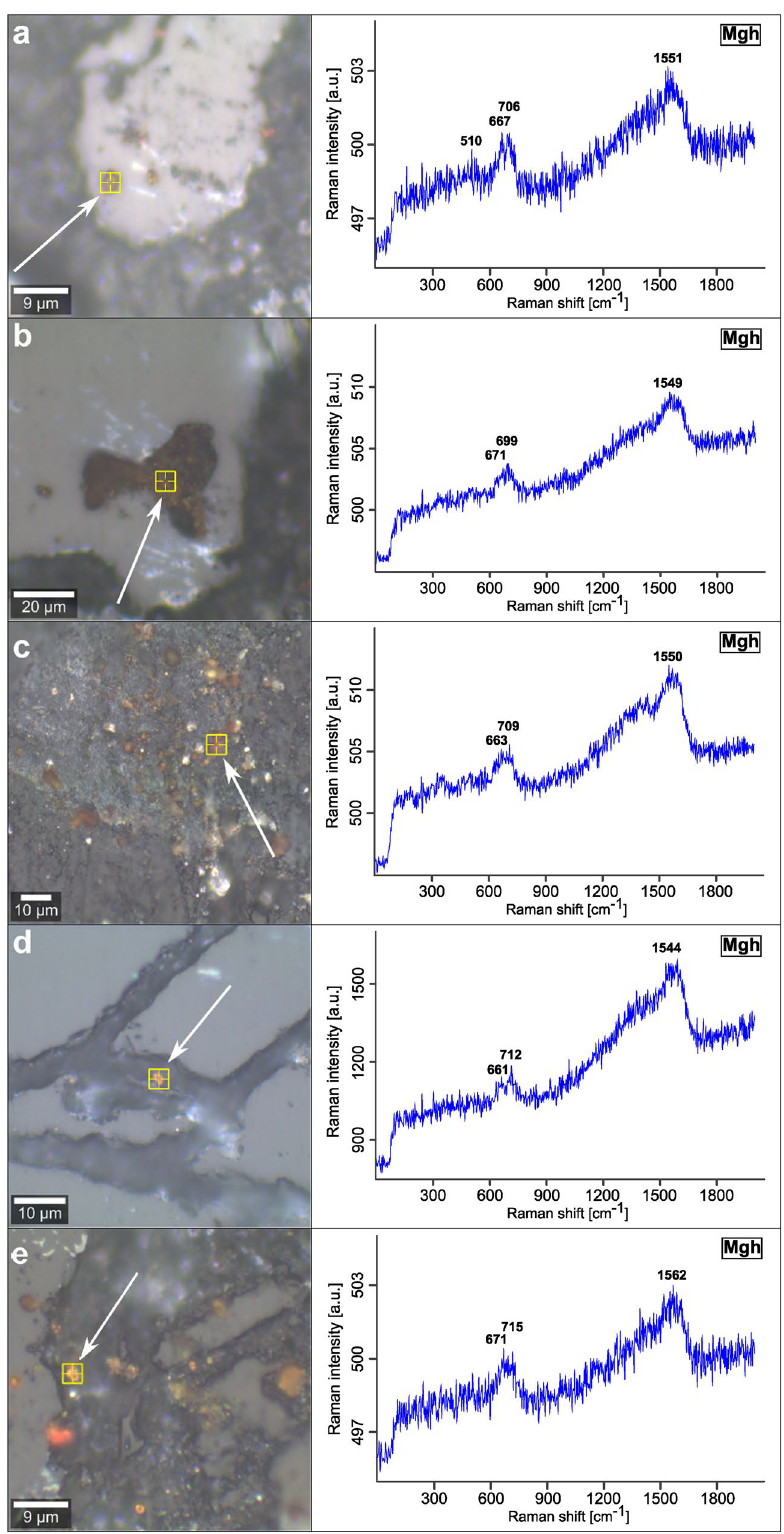
Figure 3. Raman spectra of maghemite deduced from micrometer-scale crystals embedded in soil aggregates. (a–e ) Reflected light microphotographs in combination with Raman spectra of maghemite. Bold numbers represent the wavenumbers of diagnostic Raman bands. Yellow markings indicate the localizations of the respective measurements. The crystals shown are either situated in voids of MB 2 glass ( a,b ), or occur dispersed within the organic-rich matrix of the aggregates ( c–e